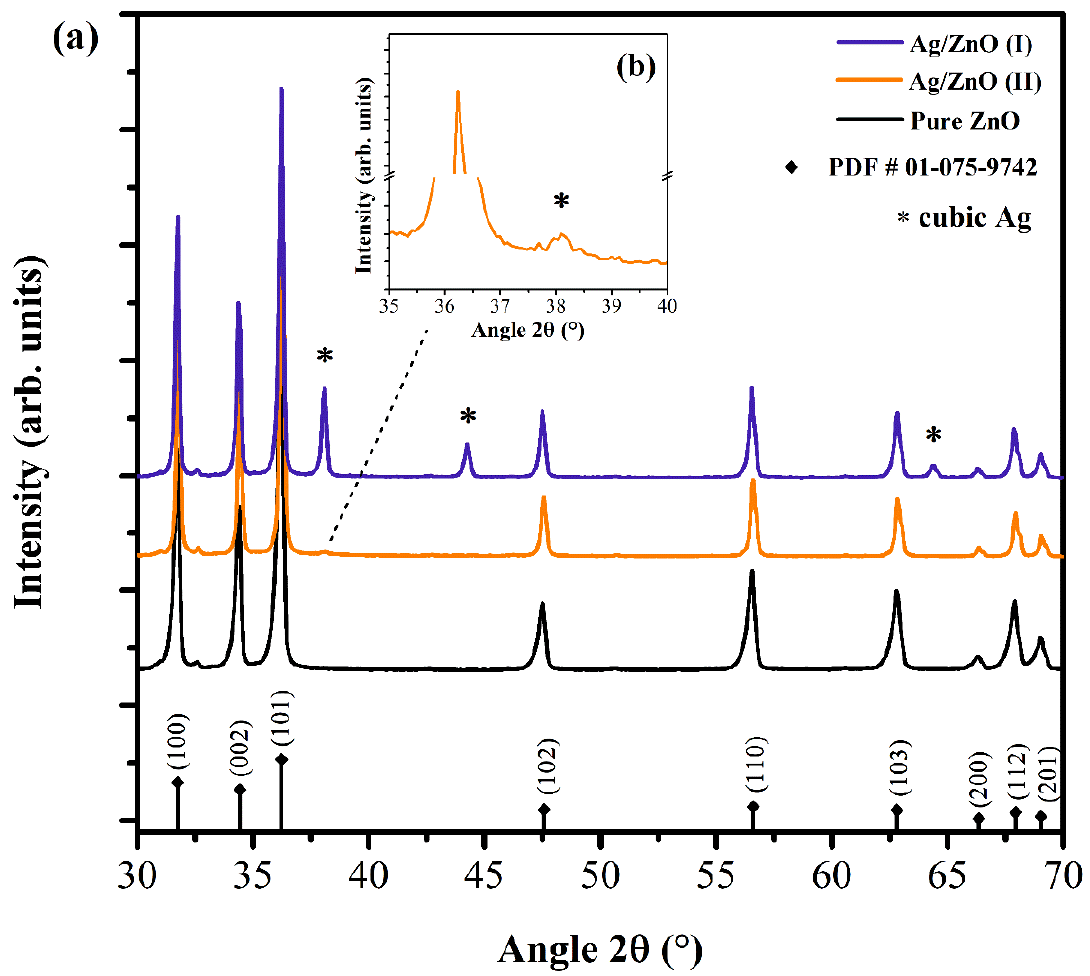
Figure 2. ( a ) XRD patterns of ZnO and Ag/ZnO prepared by route I and II; ( b ) the amplified XRD pattern in the range of 2 θ = 35 – 40 for the sample Ag/ZnO (II).